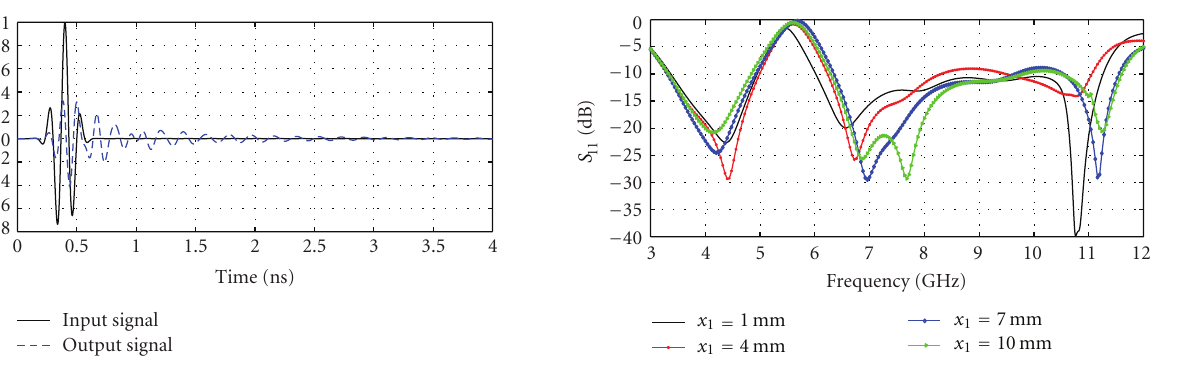
Figure 9: Simulated S 11 (dB) for values of x 1 versus frequency